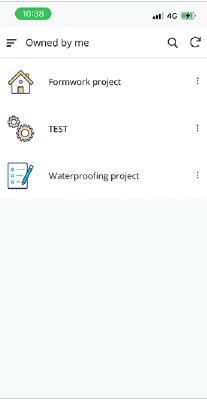
Figure 18. Screen image for design of icon corresponding to table